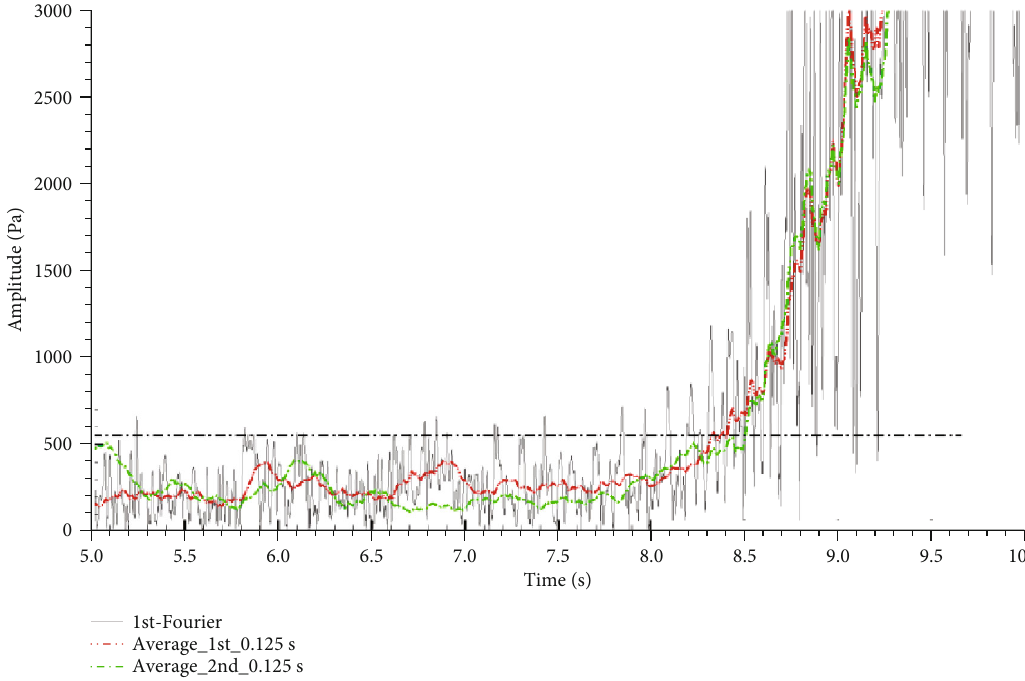
Figure 11: Mean amplitude of the fi rst- and second-order harmonic of the total pressure signal during the stall inception.